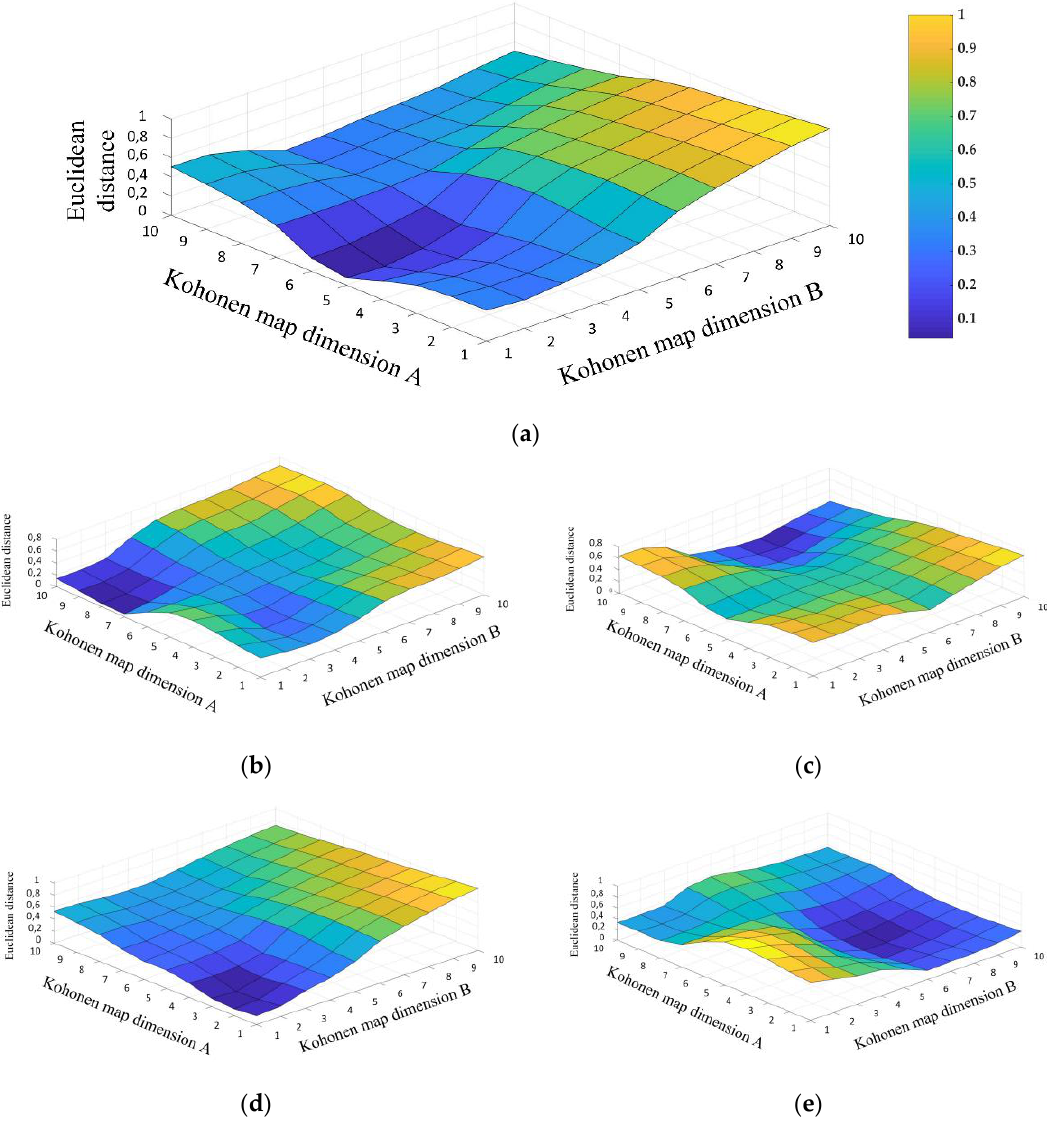
Figure 7. The SOM responses to training data vector: ( a ) no fault; ( b ) broken rotor bars; ( c ) stator winding faults; ( d ) broker rotor bars = T L ≈ 0; ( e ) mixed damages.